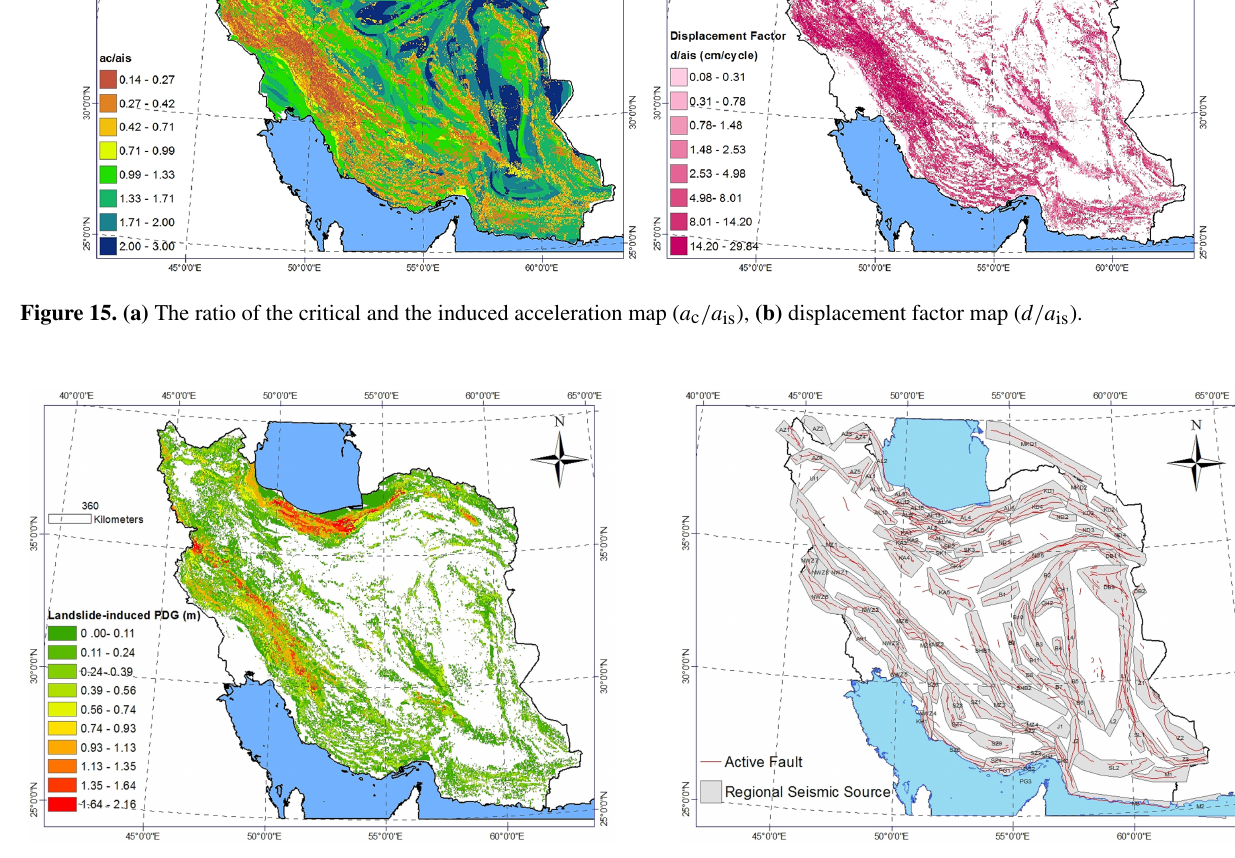
Figure 16. Landslide-induced displacement map of Iran. Figure 17. Regional seismic sources of Iran (Karimiparidari,